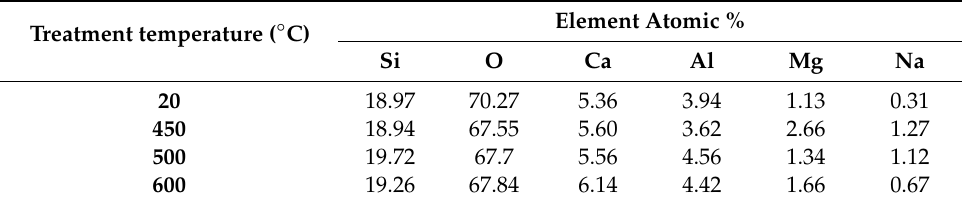
Table 1. Atomic percentages of constituent elements at the surface of boron-free E-glass from X-ray photoelectron spectroscopy